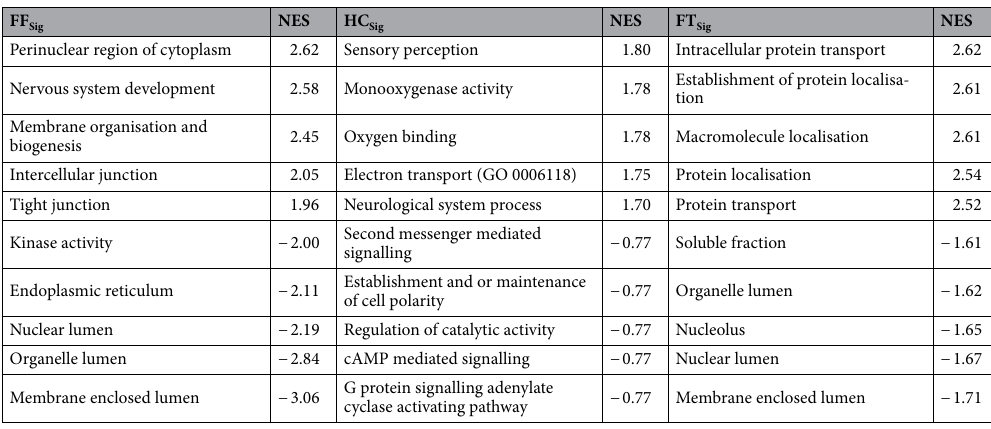
Table 5. The GO terms that have RRs with FF Sig , HC Sig and FT Sig with positive and negative associations from the NRG-S dataset.